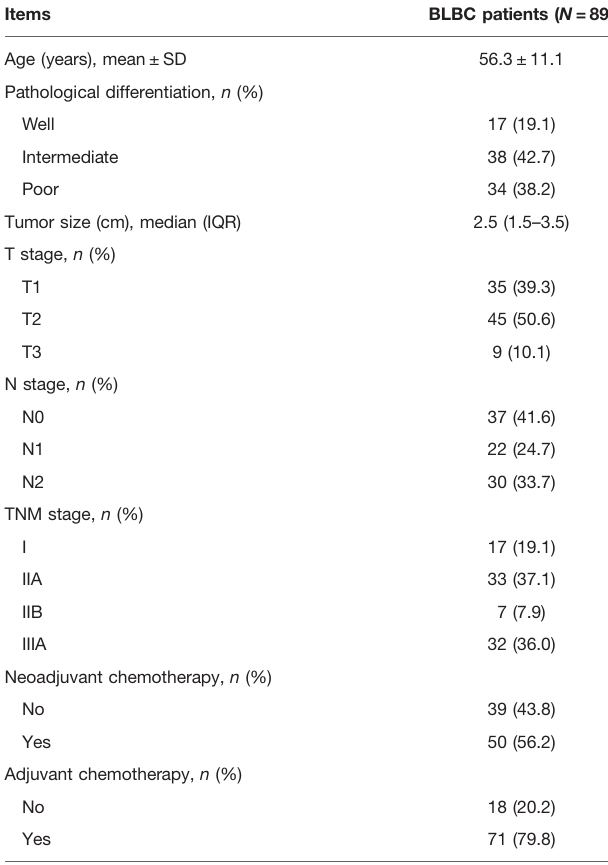
TABLE 1 | Characteristics of BLBC